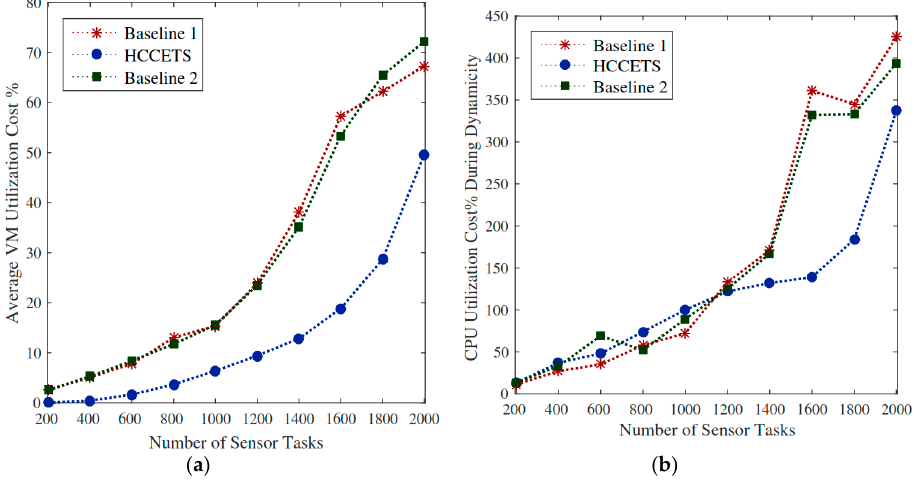
Figure 9. CPU utilization of fog servers. ( a , b ) the HCCETS incurs lower RPD% in terms of CPU utilization as compared to the existing Baseline 1 and Baseline 2.